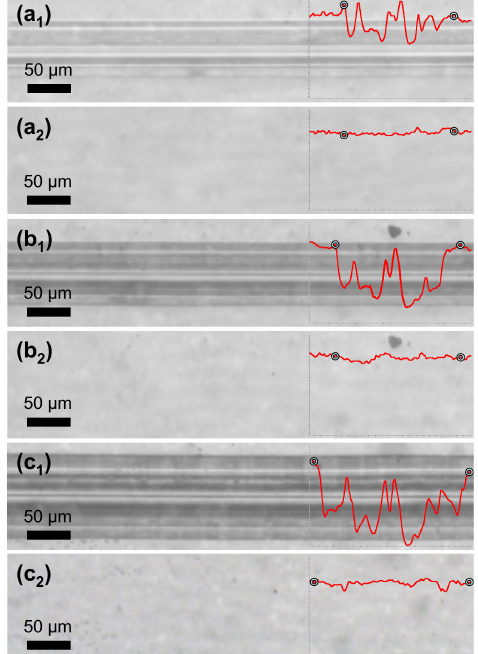
Figure 8. Shape-memory assisted scratch-healing of the quenched PETMP-TTT polymer coatings: ( a 1 ), ( b 1 ), and ( c 1 ) optical microscope digital photographs of characteristic scratch track sections before, and ( a 2 ), ( b 2 ), and ( c 2 ) after the healing process of the scratch with different constant loading of 1.2 N, 1.5 N, and 2.7 N, respectively. Insets show characteristic scratch track profiles with corresponding indicators for the beginning and the end of